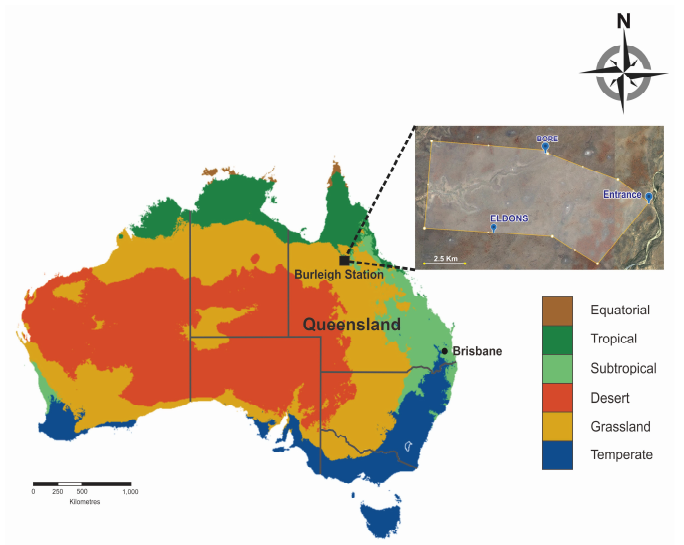
Figure 1. Location of Burleigh station showing where the automatic supplement weighing (ASW) units were placed within the experimental sites.